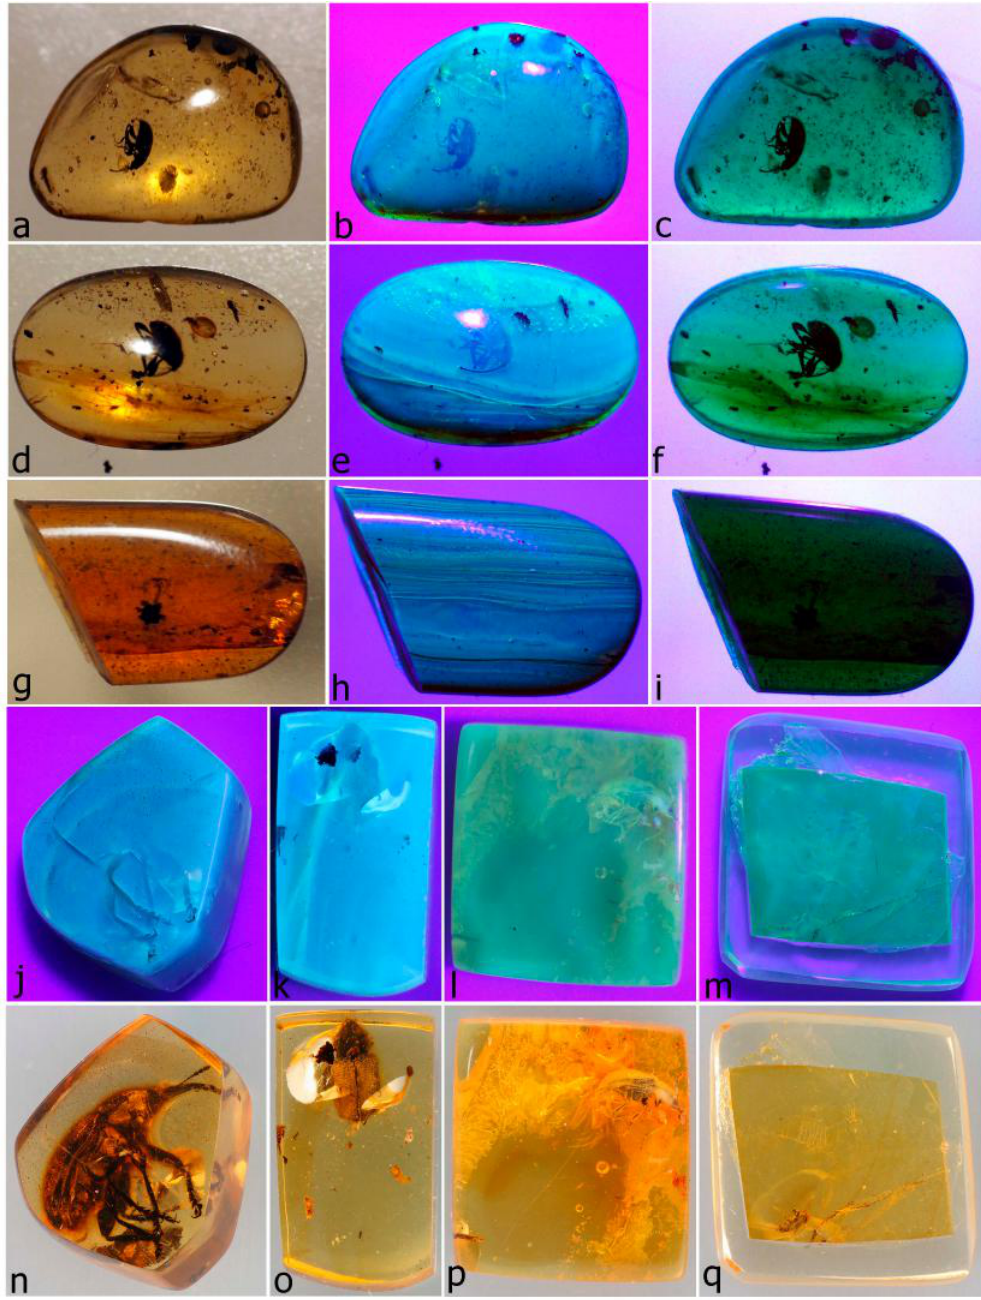
Figure 1. Amber in white light ( a , d , g , n – q ), incident near-ultraviolet (UVA) ( b , e , h , j – m ) and reflected UVA light ( c , f , i ). Amber piece containing specimen of Bowangius sp. 2 ( a – c ); amber piece containing specimen of Mekorhamphus beatae ( d – f ); Burmese amber offcut ( g – i ); amber piece containing specimen of Opeatorhynchus comans ( j , n ); amber piece containing holotype of Mekorhamphus gyralommus ( k , o ); Baltic amber piece containing a specimen of Baltocar sp. ( l , p ); amber piece containing holotype of Microborus inertus ( m , q ).